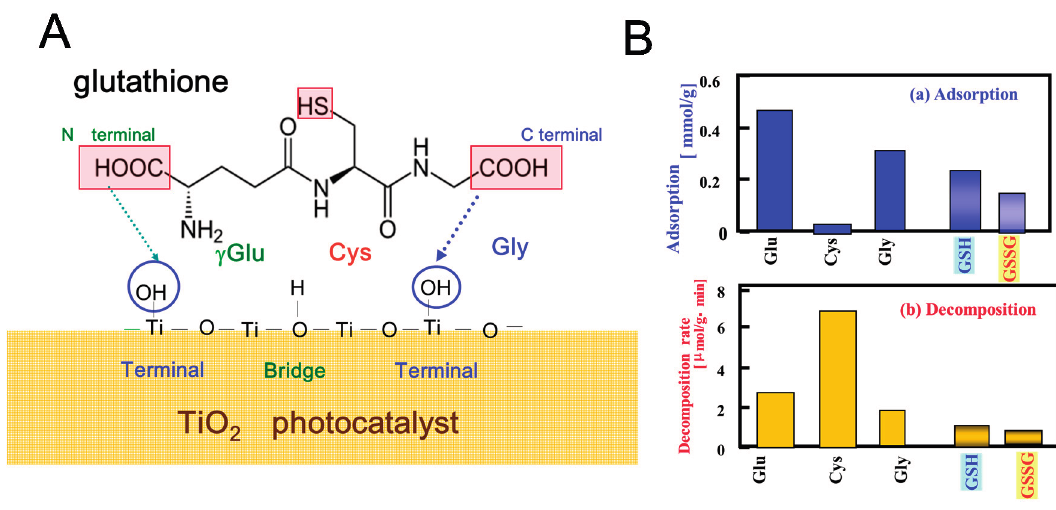
Figure 16. ( A ) Schematic presentation of the plausible adsorption of glutathione on the surface of TiO 2 (ST-01); ( B ) ( a ) Adsorption and ( b ) decomposition rates of glutathione (GSH and GSSG) and the constituent amino acids (Glu, Cys, and Gly) in aqueous suspension of TiO 2 (5 mg/0.4 mL D 2 O) under UV irradiation at 297 K. Reprinted with permission from [47] © 2012 American Chemical